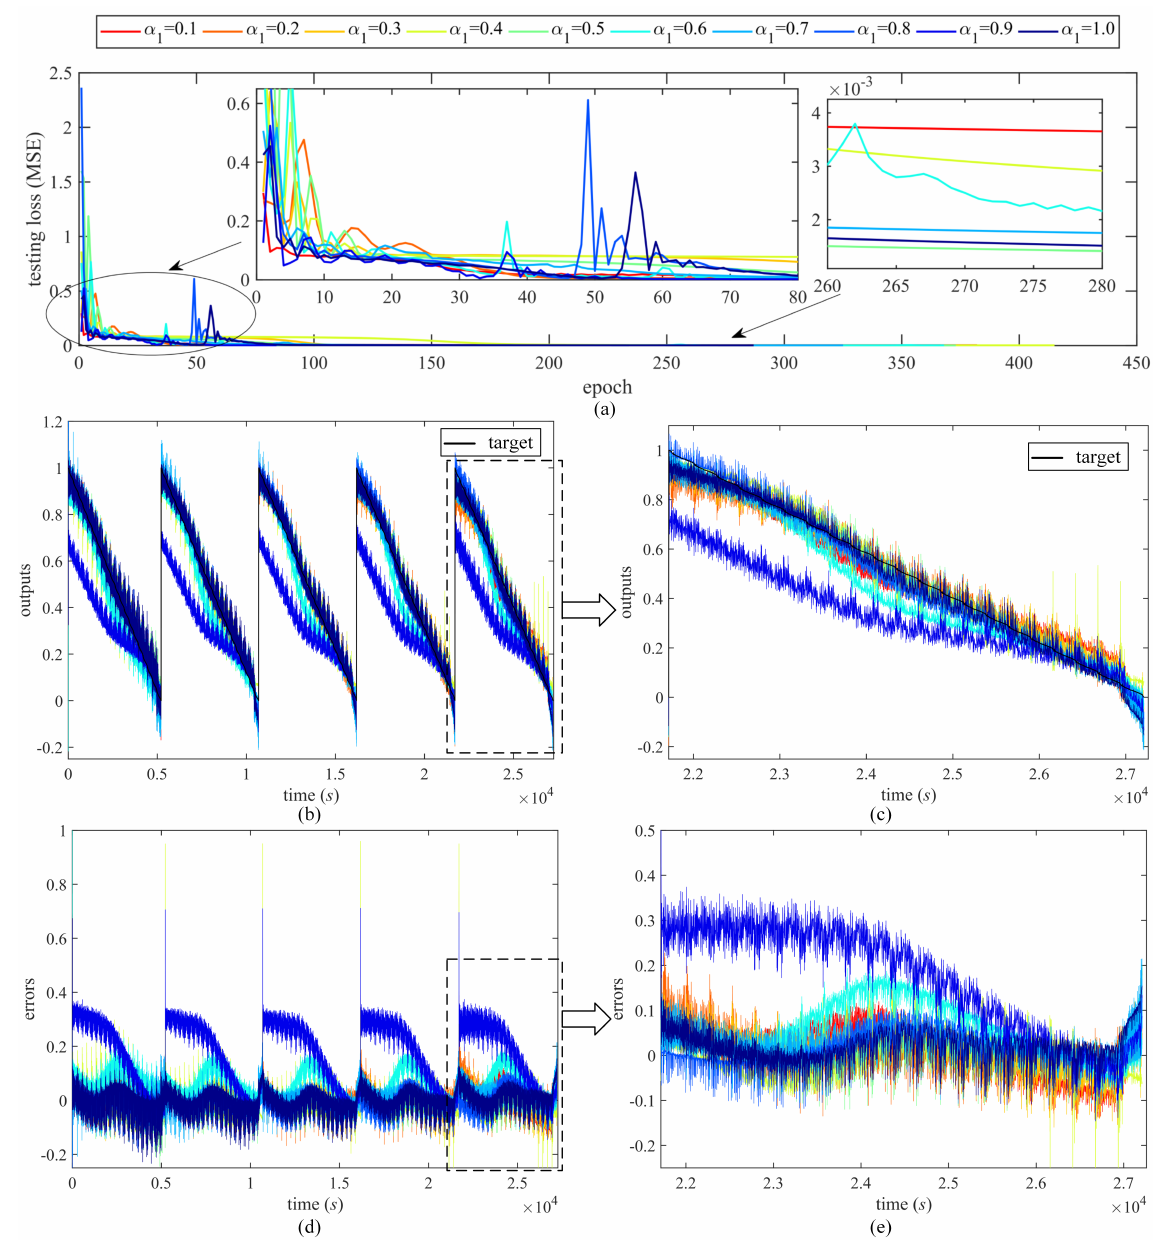
Figure 8. Sensitivity of the fractional order α 1 in FOGD and FOGDm method, α 1 = 0.1:0.1:1, ( a ) testing loss, ( b ) outputs of all dataset including training, validation, and testing data, ( c ) outputs of testing dataset, ( d ) errors of all dataset, ( e ) errors of testing